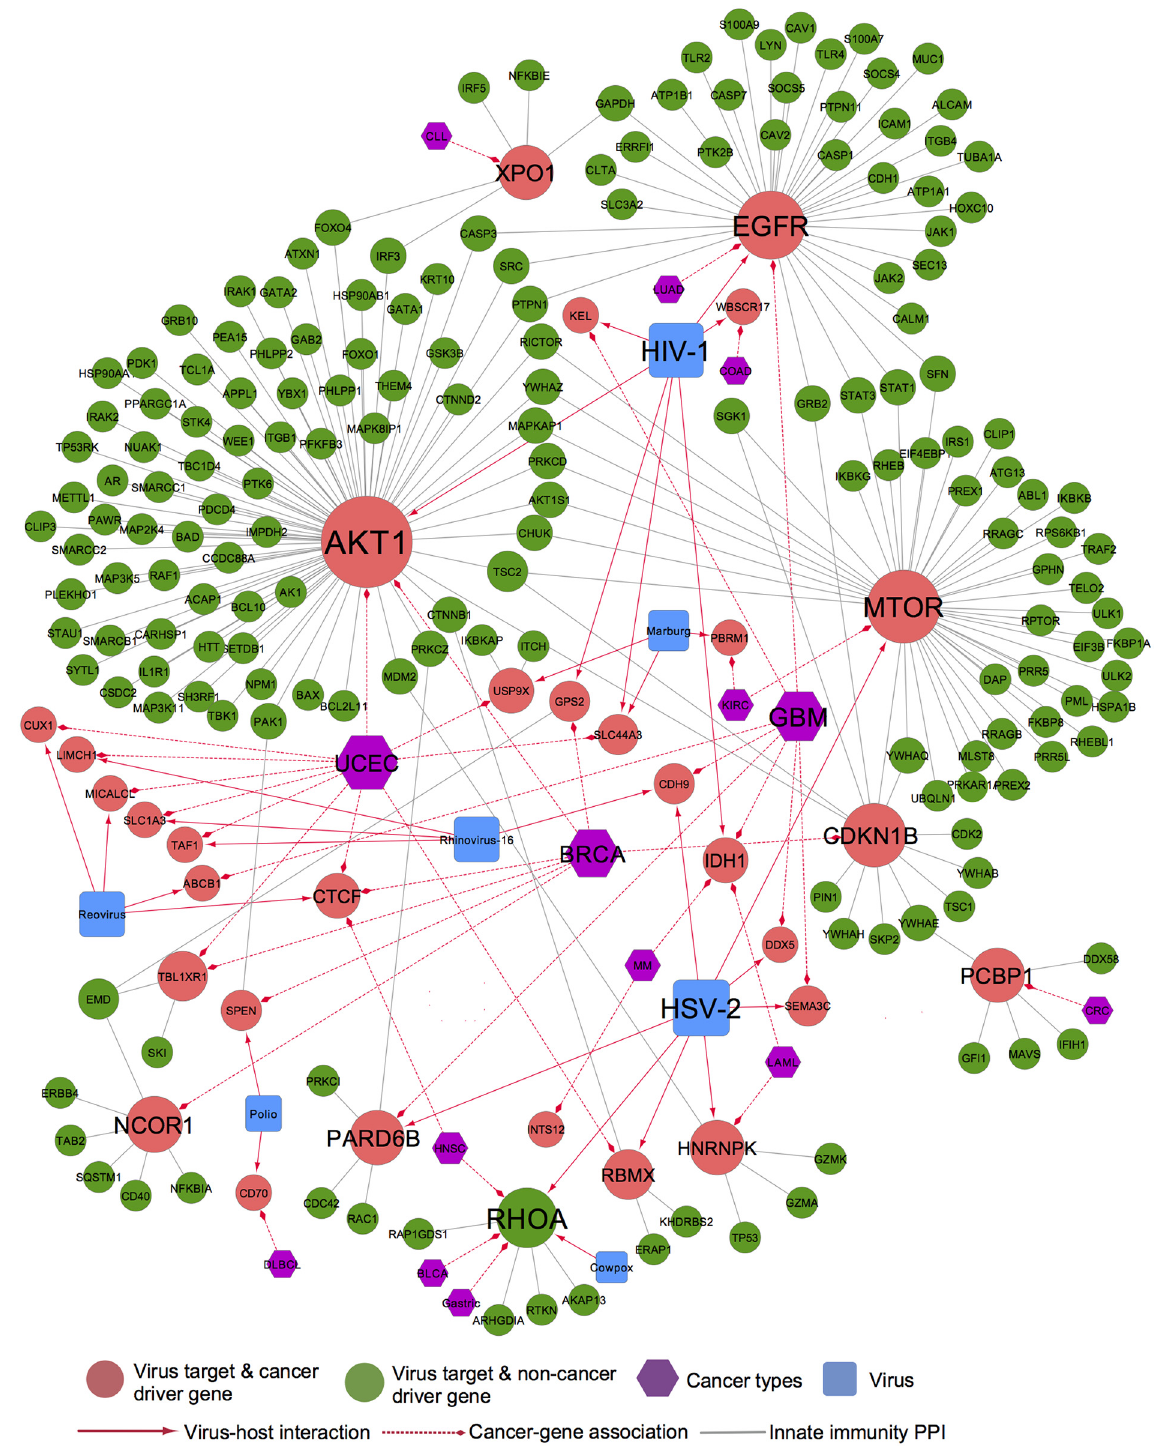
Fig 6. Novel viral perturbations of the innate immunity network reveal new cancer etiologies. In this network, nodes represent viruses (squares), cancer types (hexagons), and genes (circles). Edges represent virus-host interactions (solid red arrows), cancer- gene associations (striped red arrows), and innate immunity protein-protein interactions (solid gray lines). Various cancer types represented are abbreviated as follows: breast invasive carcinoma (BRCA), bladder urothelial carcinoma (BLCA), colon adenocarcinoma (COAD), diffuse large B-cell lymphoma (DLBCL), glioblastoma multiforme (GBM), head and neck squamous cell